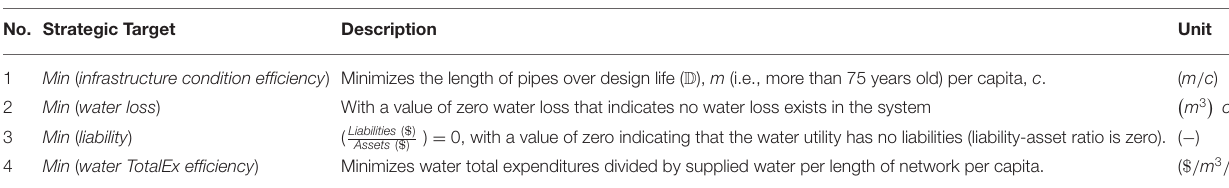
TABLE 2 | Strategic targets for asset management strategy of water distribution network.